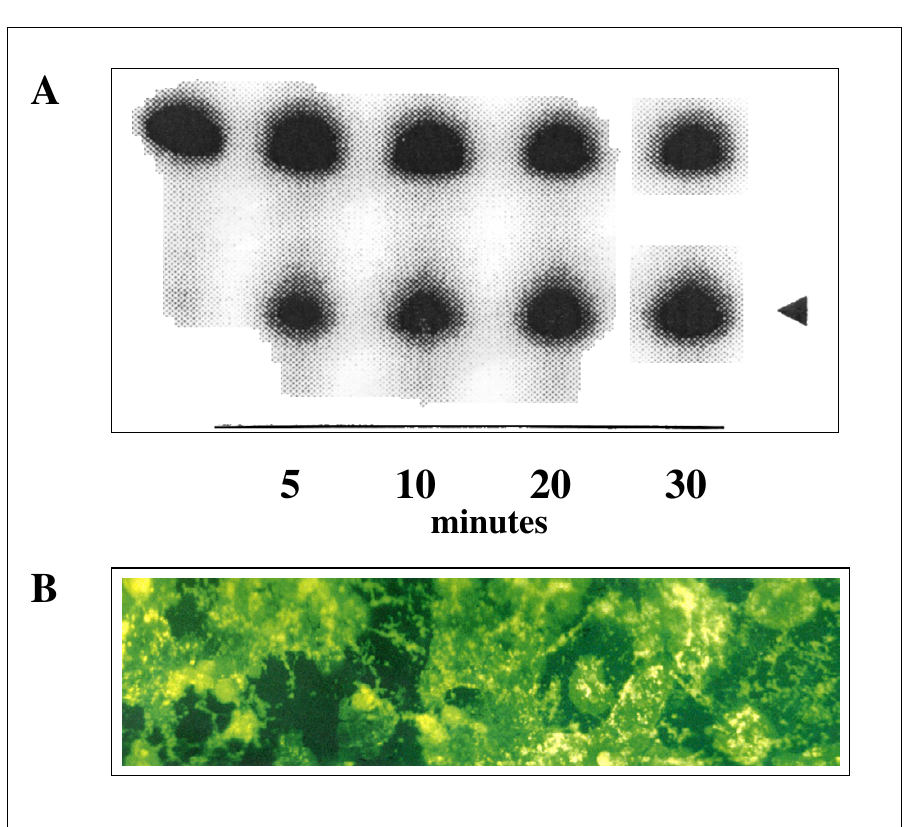
Figure 2 G i2 α ribozyme. A: Ribozyme in vitro cleavage activity. A PhosphorImager (Molecular Dynamics, Sunnyvale, CA, USA) printout of a 15 % polyacrylamide gel with 7 M urea. The 5'-end-labelled RNA substrate (200 nM) was incubated with the ribozyme (75 nM) in reaction buffer as described in Materials and Methods. 10 µ l samples were taken at the indicated time, added to 5 µ l quenching solution and then analysed by electrophoresis. The arrow indicates cleavage products. B: Ribozyme uptake in cul- tured hepatocytes. Hepatocytes were transfected with 5'-FITC-labelled ribozyme for 30 h. Following washing with phosphate- buffered saline (PBS), cells were analysed by fluorescence